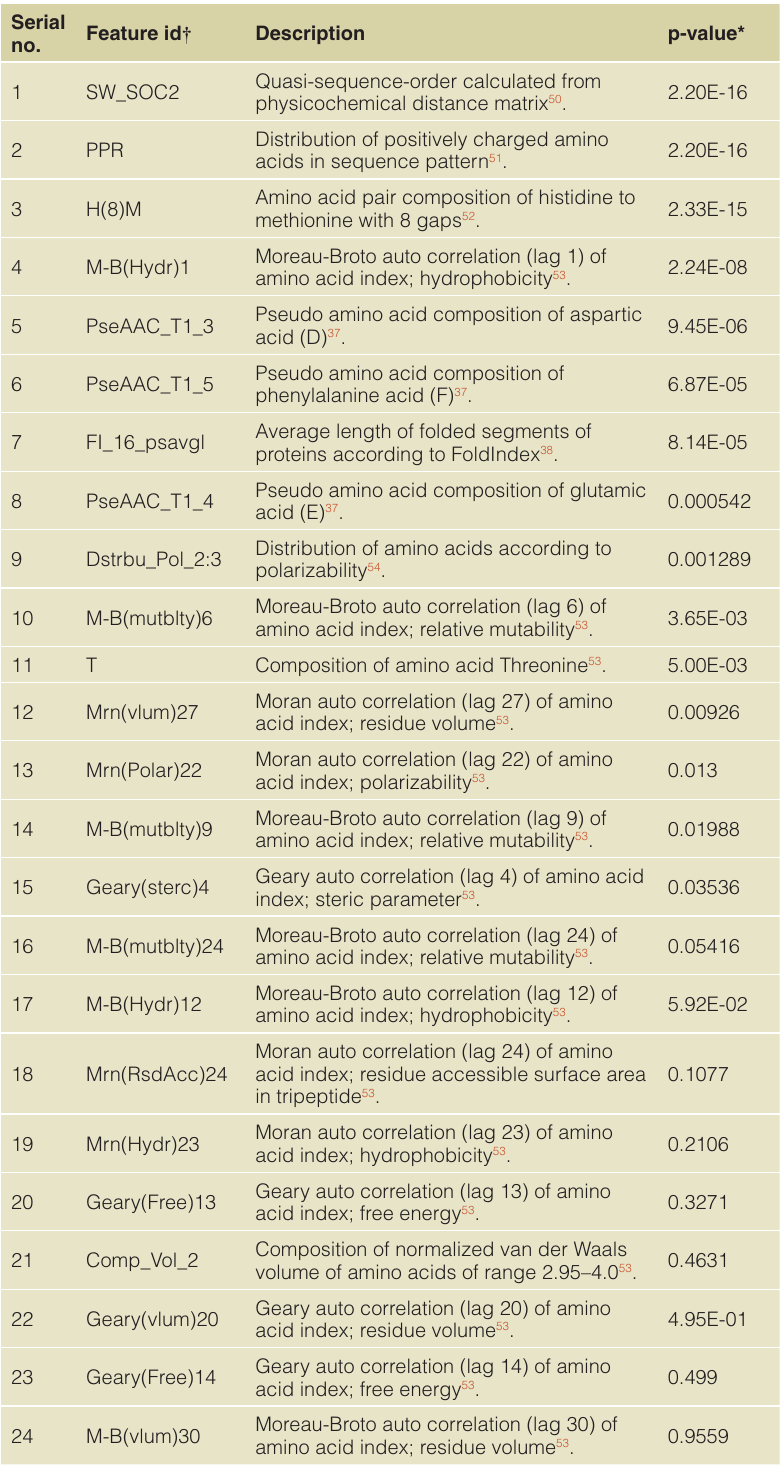
Table 2. Selected features of proteins used to build the “SolubEcoli.pgc” classifier. Serial